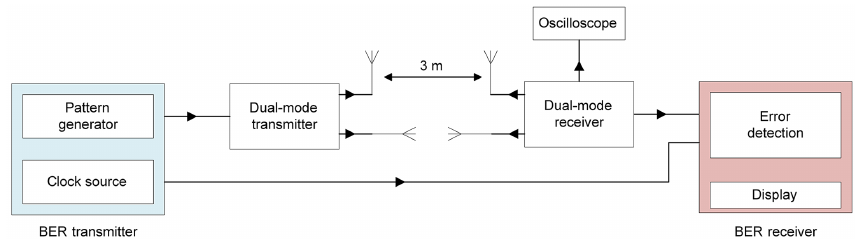
Figure 8. Setup for wireless CAN bit error measurement and measurement of the eye diagram.